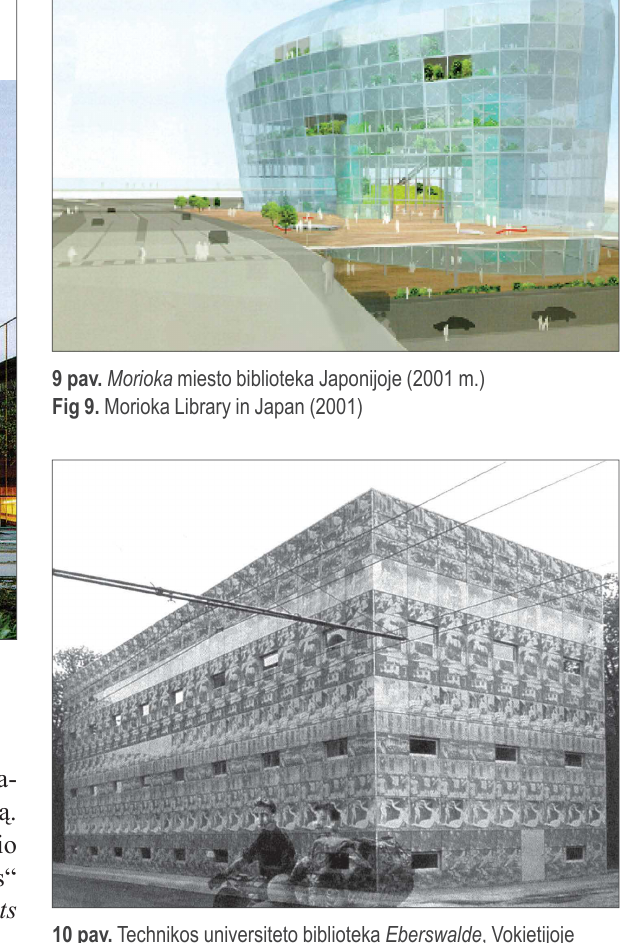
(1994–1999 m.) Fig 10. Eberswalde Technical University Library in